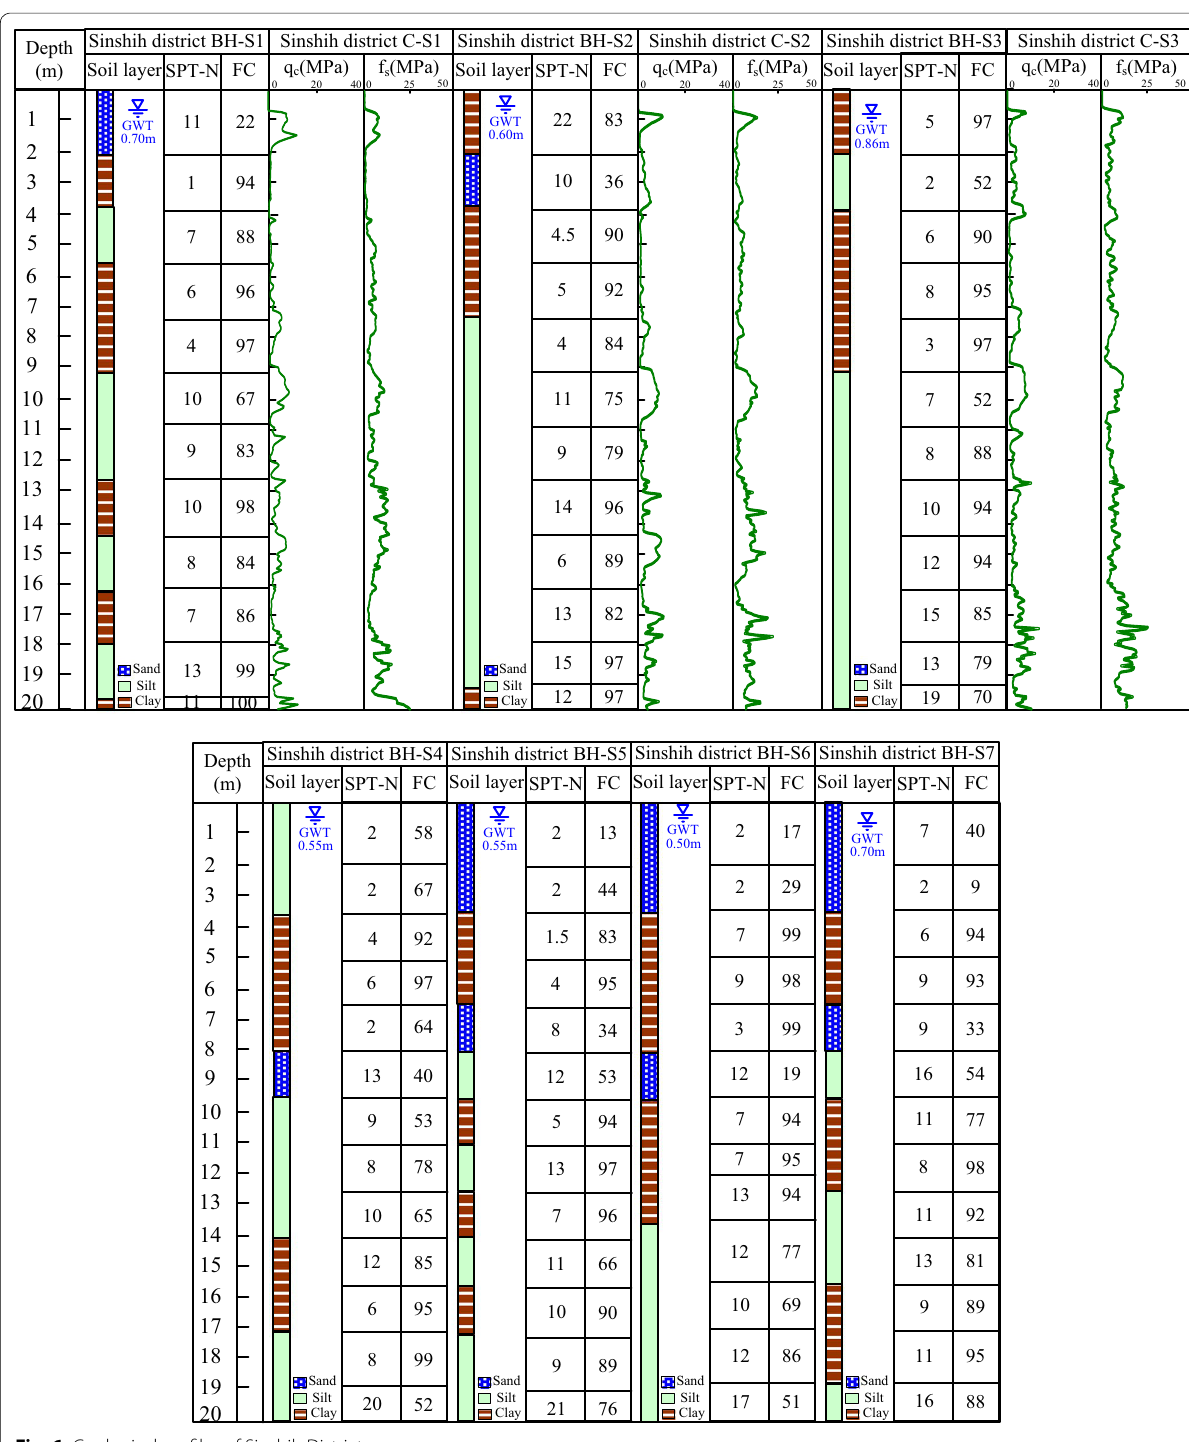
Fig. 6 Geological profiles of Sinshih